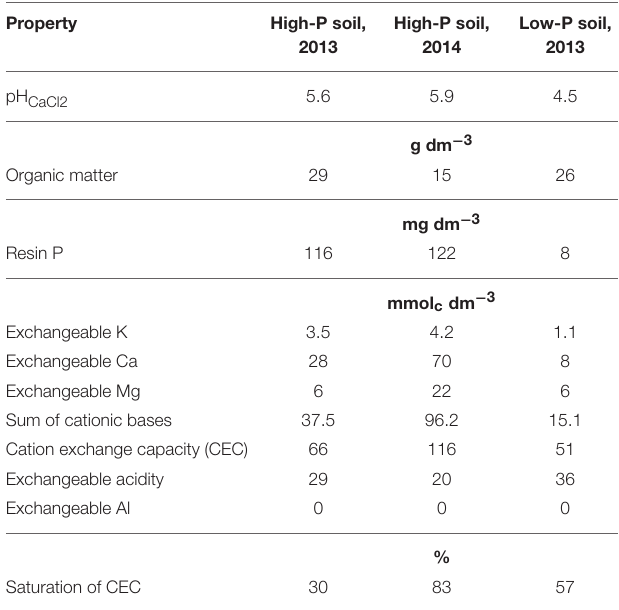
TABLE 3 | Properties of red clay latosols at experimental sites in 2013 and